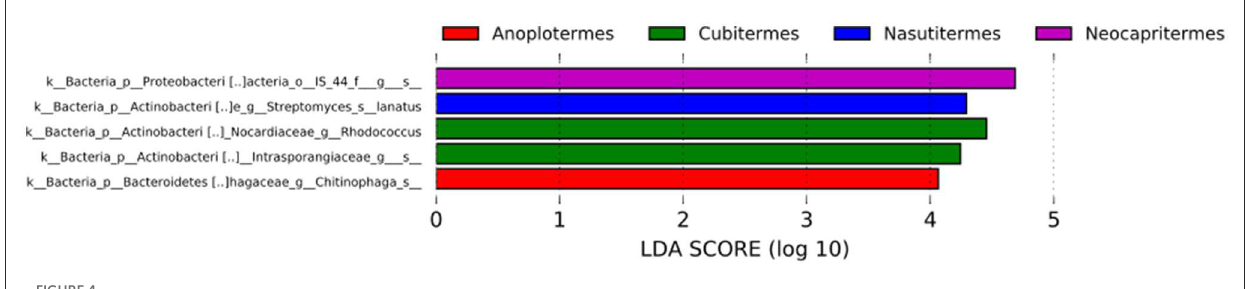
FIGURE4 LEfSe results. LDA score (log 10) for each category per genus is